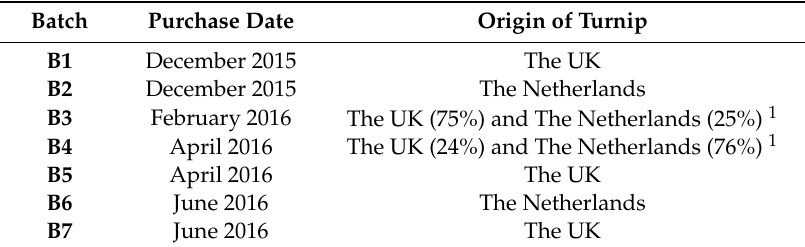
Table 1. Purchase date and the origin of turnips for each batch.